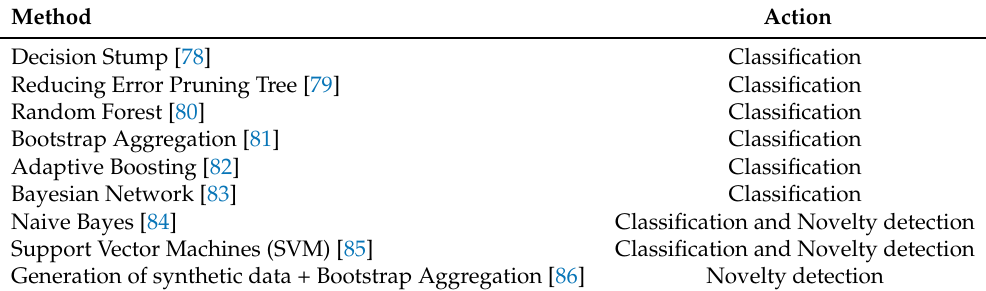
Table 3. Battery of pattern recognition